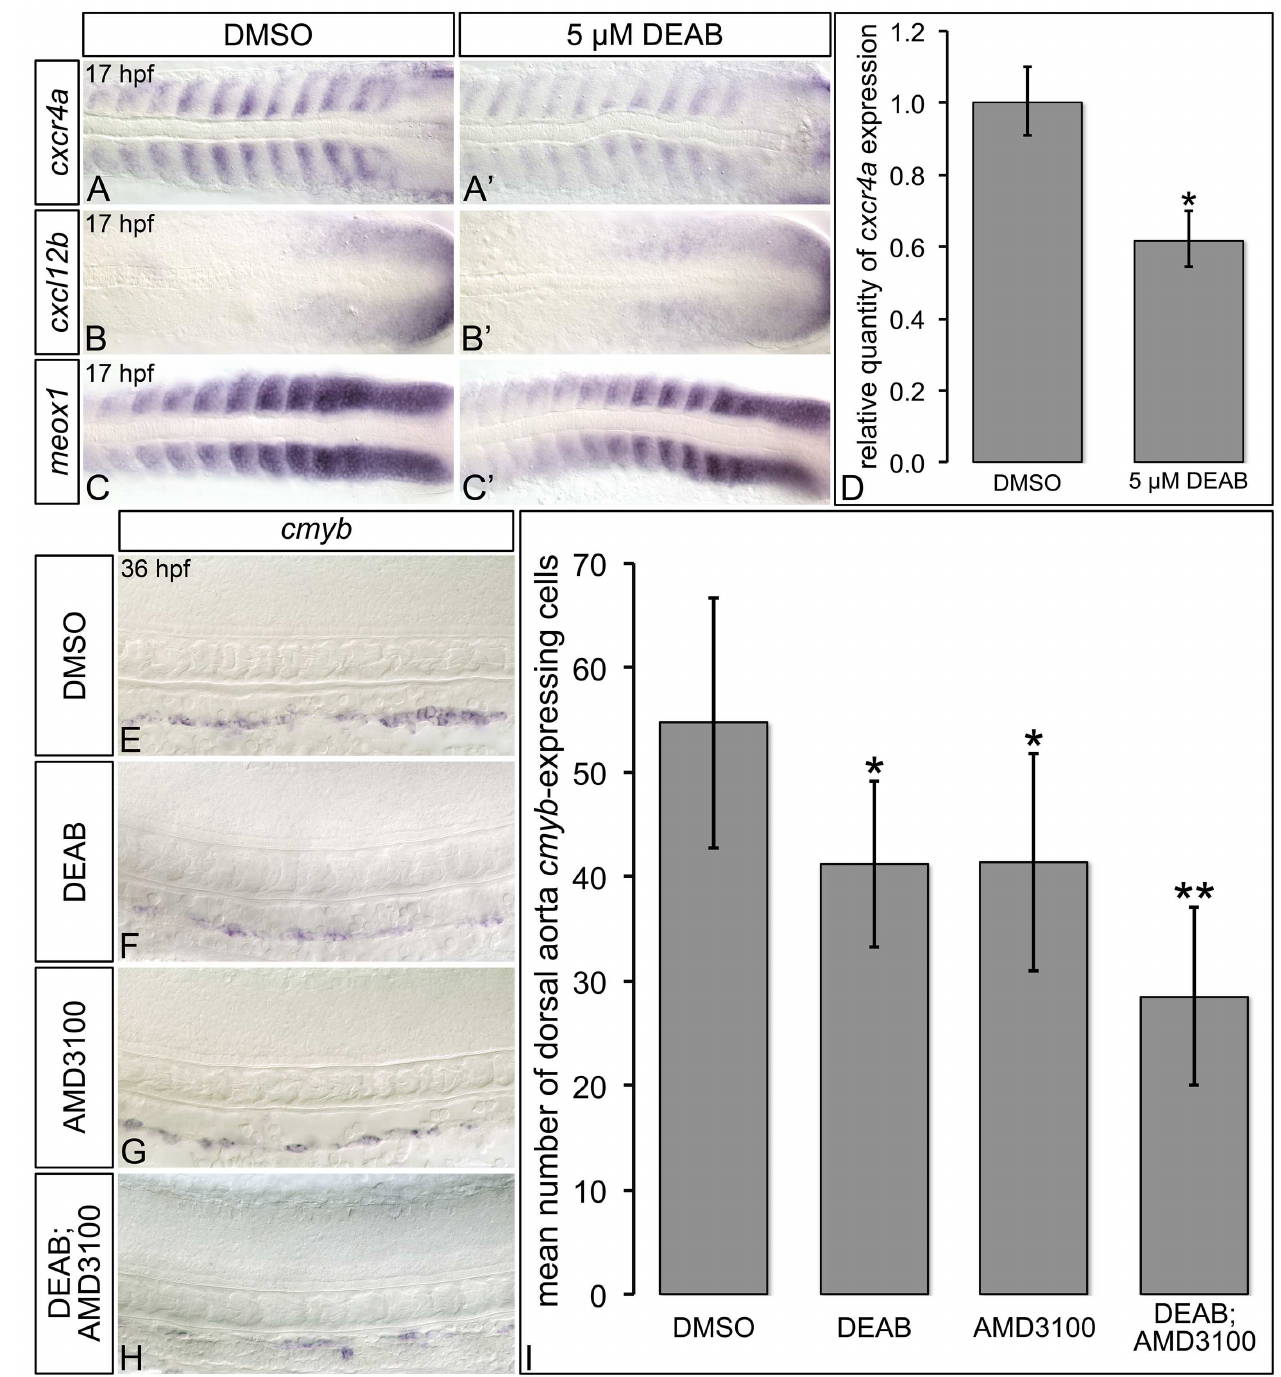
Fig 7. RA-deficient embryos exhibit altered Cxcl12b chemokine signaling pathway component gene expression. (A-C’) Representative flat-mount 17 hpf embryos following in situ hybridization analyses. Dorsal of gene expressionis shown with anterior to the left. Comparedto DMSO- treated controls (A), embryos treated with 5 μ M DEAB (A’) exhibit strongly reducedsomitic cxcr4a geneexpression, and narrowingof the cxcr4a expressiondomain within each somite. Compared to DMSO-treated controls (B, C), embryos treated with 5 μ M DEAB exhibit subtly increased levels of somitic cxcl12b expression(B’), and subtly decreased levels of somitic meox1 expression(C’). (D) Quantitative real-time PCR analysisof cxcr4a expressionin 17 hpf DMSO-treated controls and embryostreated with 5 μ M DEAB. Shown is the relative quantity of cxcr4a expression. Samples were normalized to ef1a and DMSO-treated was set to 1. Error bars indicatestandard error of the mean. * Indicatesthe difference